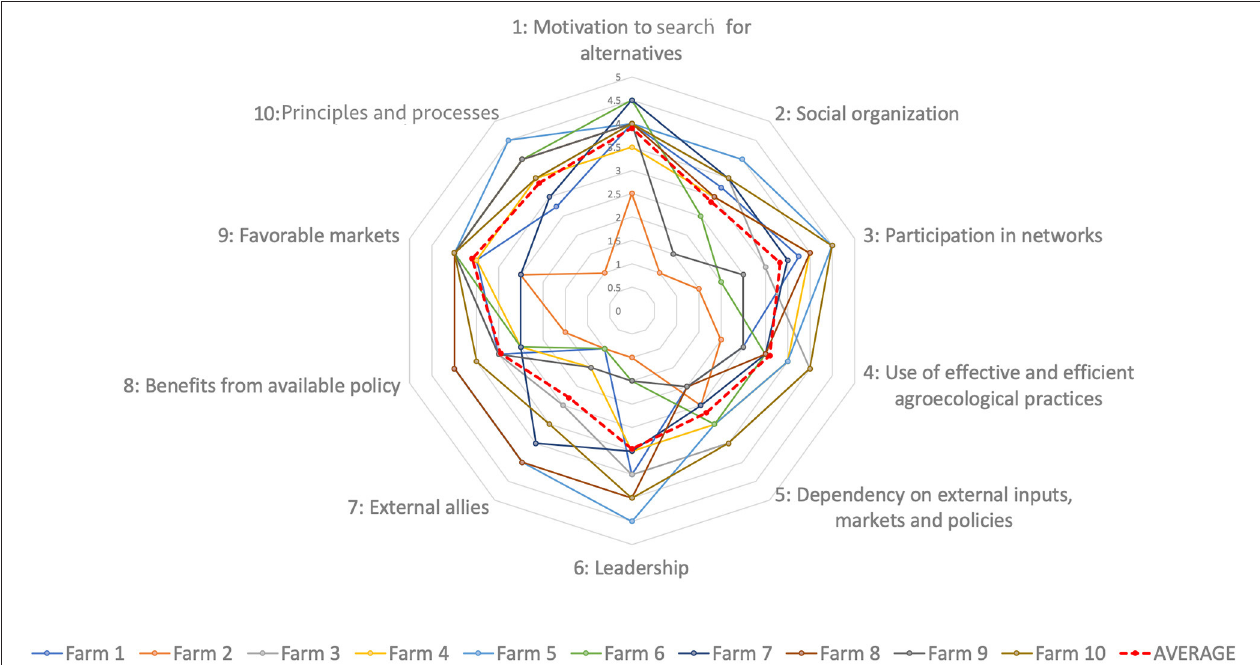
FIGURE 1 | Assessment of amplification potential for a sample of nine farmers and farms identified as farmer lighthouses (source: Authors).